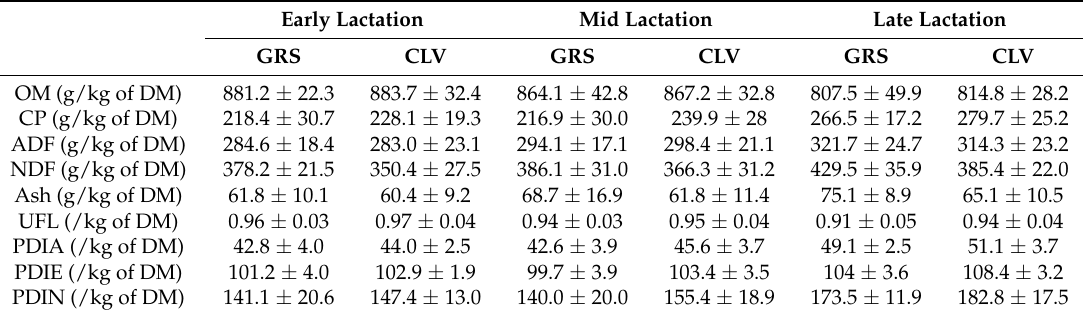
Figure 4. Variable importance plot (VIP) which shows the compounds primarily responsible for separation of rumen fluid metabolomes from cows fed diets consisting of total mixed ration (TMR), perennial ryegrass (GRS), or perennial ryegrass and white clover (CLV), as determined by PLS-DA. Table 2. Chemical composition and nutritional content (mean ± SD) of pasture system forages (GRS and CLV), collected weekly throughout lactation, analysed by near-infrared spectroscopy. Early